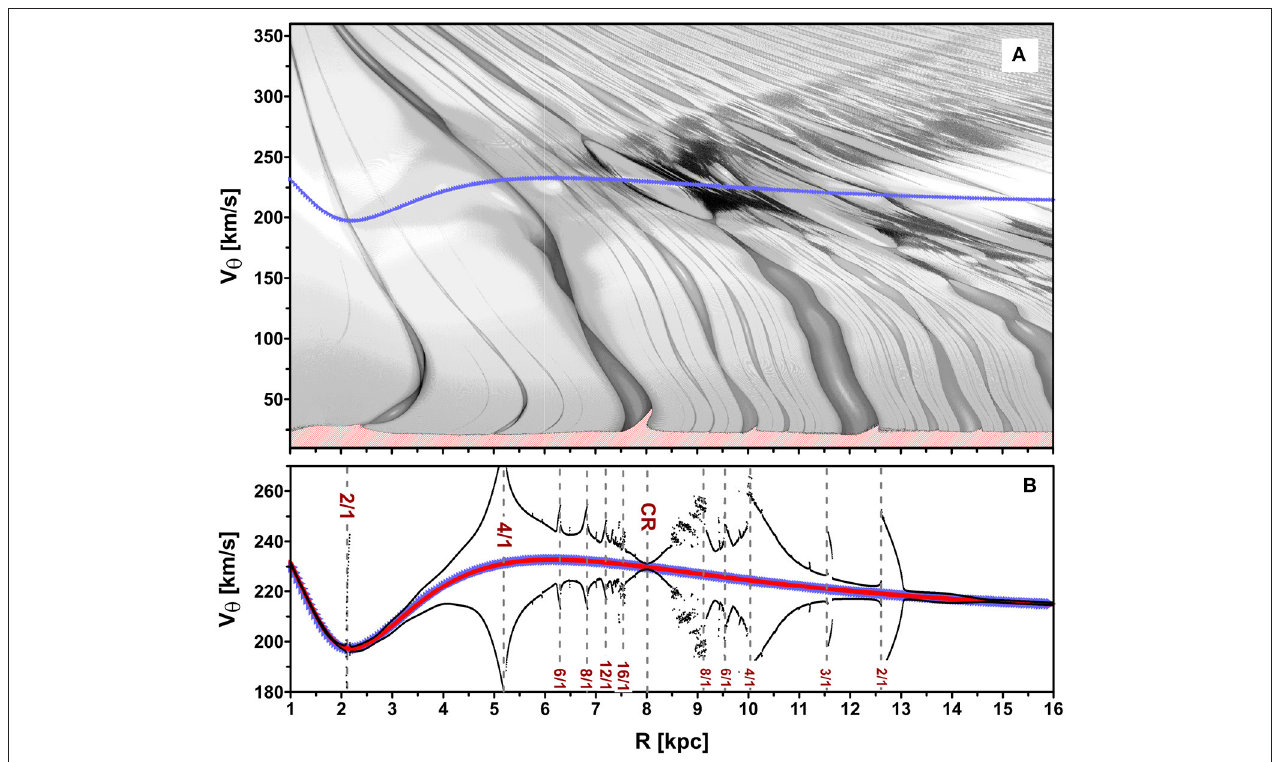
FIGURE 3 | (A) Dynamical map on the R – V θ plane constructed with the parameters of the Galactic model described in section2 and the initial p R = 0 and ϕ = 76 ◦ (see text). The light gray tones represent regular orbits, while increasingly dark tones correspond to increasing instabilities and chaotic motion. The rotation curve of Equation (2) is shown by the blue curve. (B) The averaged (red) and minimal/maximal (black) values of the V θ –variable calculated over 10Gyr as function of initial values of R . The vertical dashed lines indicate the locations of the epicyclic (Lindblad) resonances, as well as of the CR. One can compare the correspondence of the resonances with the ones shown in the bottom panel of Figure 1